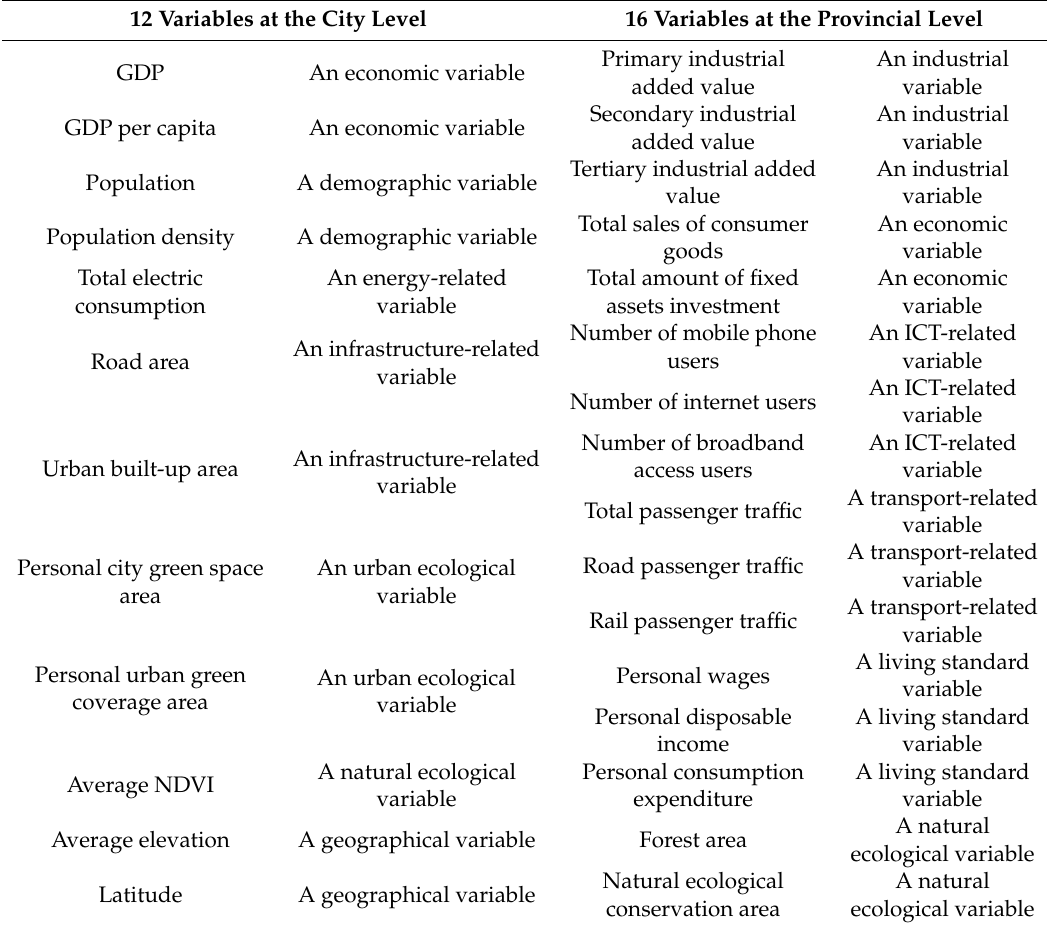
Table 1. Selection of variables at the city level and provincial